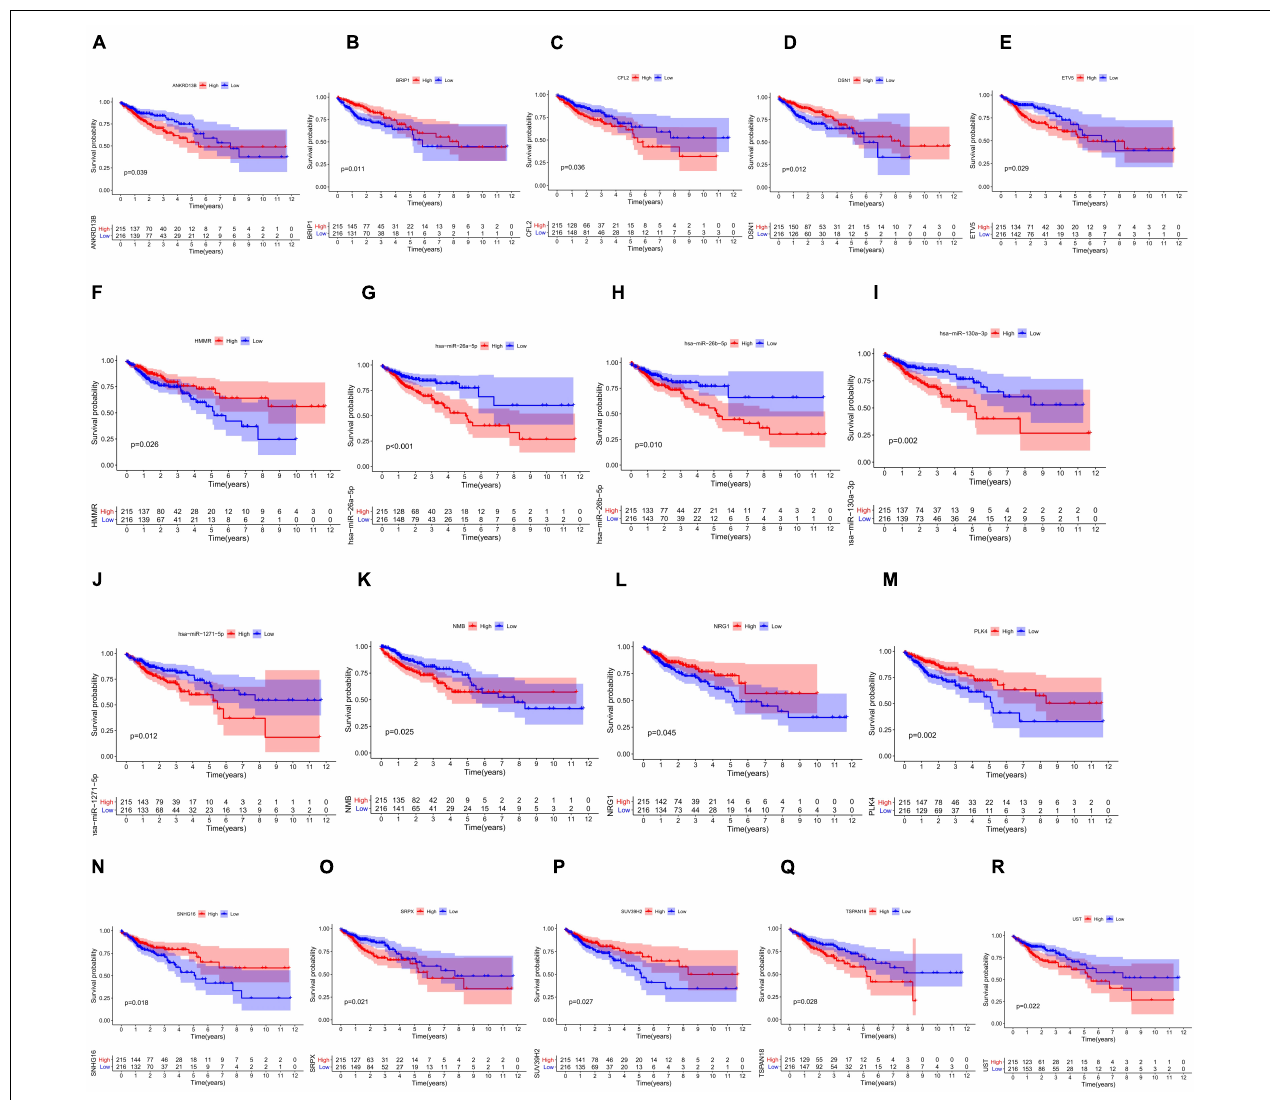
FIGURE 2 | (A–R) Survival curves of 18 RNAs that are significantly related to the prognosis of colon cancer